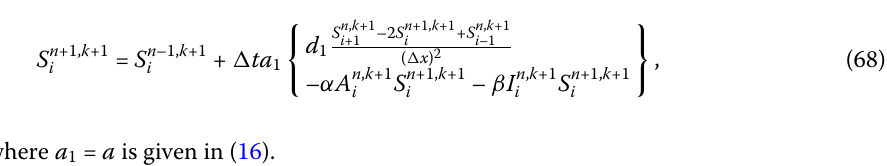
When the Gauss-Seidel iterative is employed on the difference equations obtained by dis- cretizing Eq. (1) using the proposed scheme, it